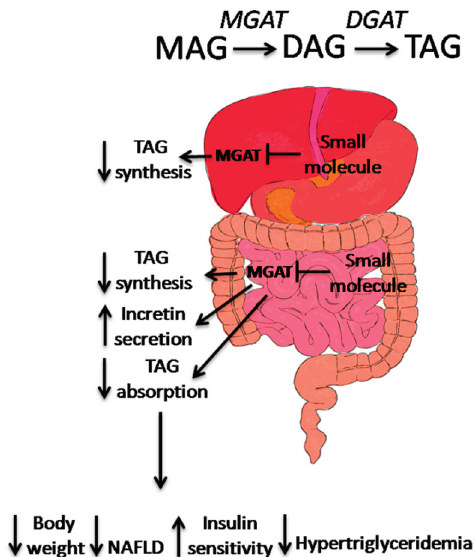
Figure 2. The mode of action of MGAT2 inhibitors in the treatment of metabolic disorders. In mouse liver, inhibition of MGAT1 has shown to improve insulin sensitivity as well as hepatic steatosis. In human liver, MGAT2/MGAT3 expression is correlated with progression of NAFLD, in the small intestine, MGAT2 inhibition results in changes in TAG absorption and synthesis, as well as incretin secretion. These actions contribute to the weight loss, improvement of insulin sensitivity and hypertriglyceridemia, and prevention of NAFLD